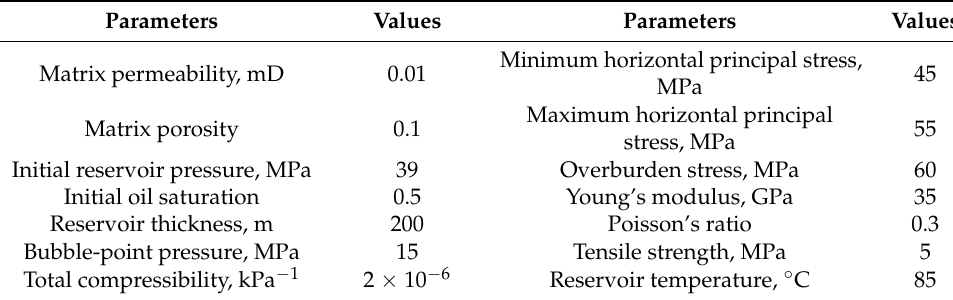
Figure 1. Illustration of the re-stimulation process. Table 1. Field data for oil layer of the base